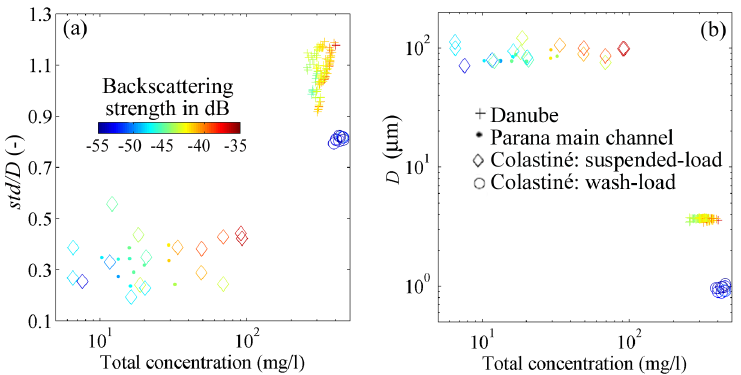
Figure 10. Assessed backscattering strength among samples ( a ) for changing concentration and standard deviation over corresponding mean size ratio, std/D , and ( b ) for changing concentration and mean size, D .